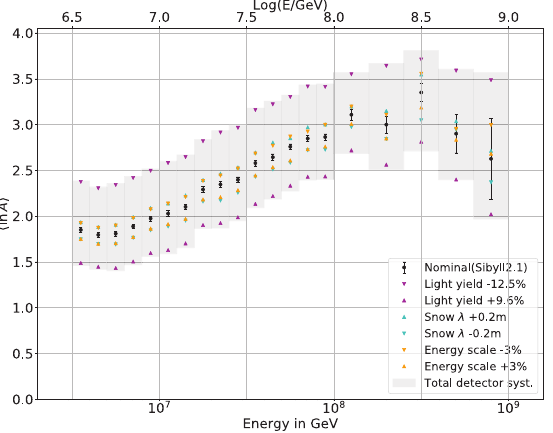
Figure 7: Calculated mean logarithmic mass (cid:4) ln A (cid:5) with the total detector uncertainty(grey) from the combination of the light yield of the in-ice detector, snow correction and energy scale uncertainty [5].